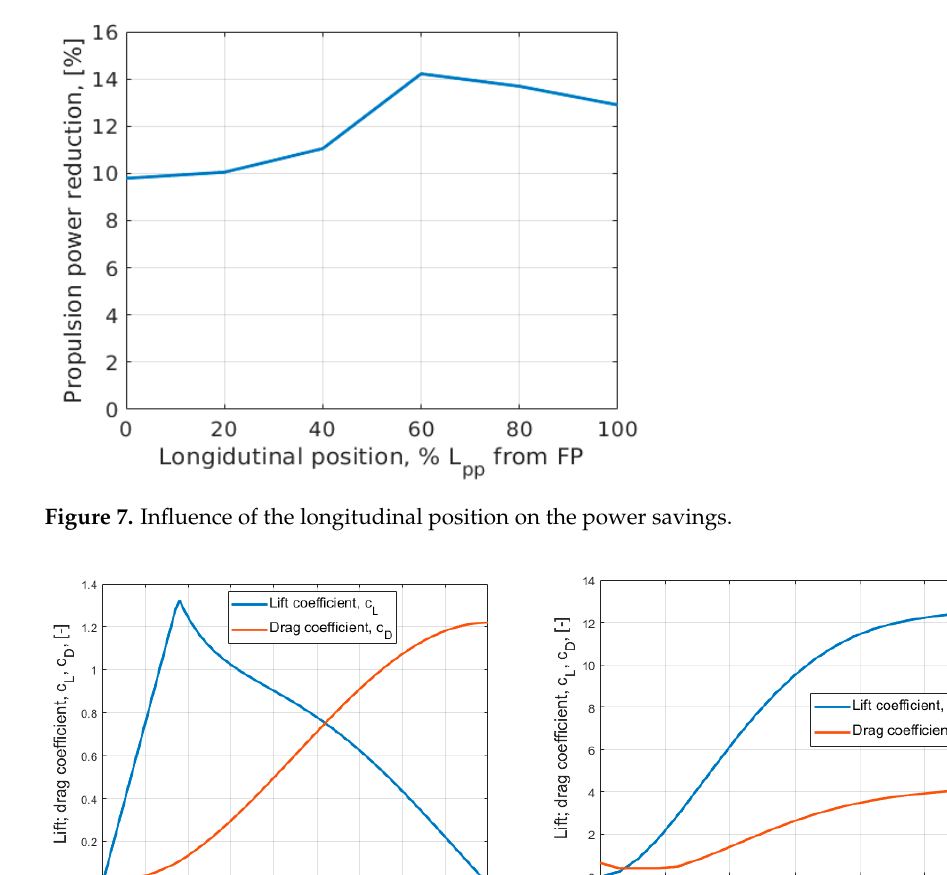
Figure 7. Influence of the longitudinal position on the power savings.